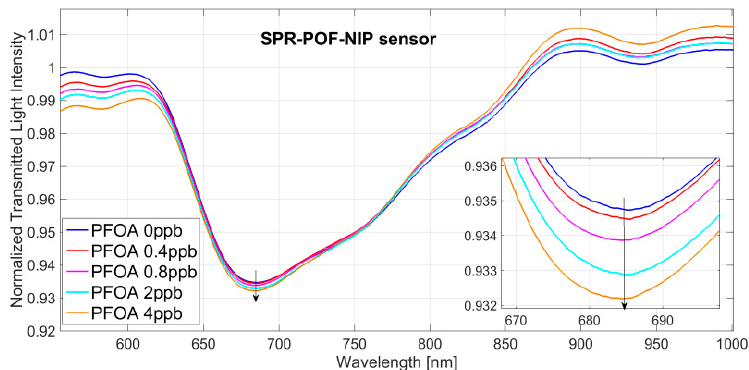
Figure 5. SPR spectra obtained at different concentrations of PFOA in water solution (0–4 ppb) by an SPR-POF platform with an NIP layer. Inset: zoom of the resonance wavelengths.